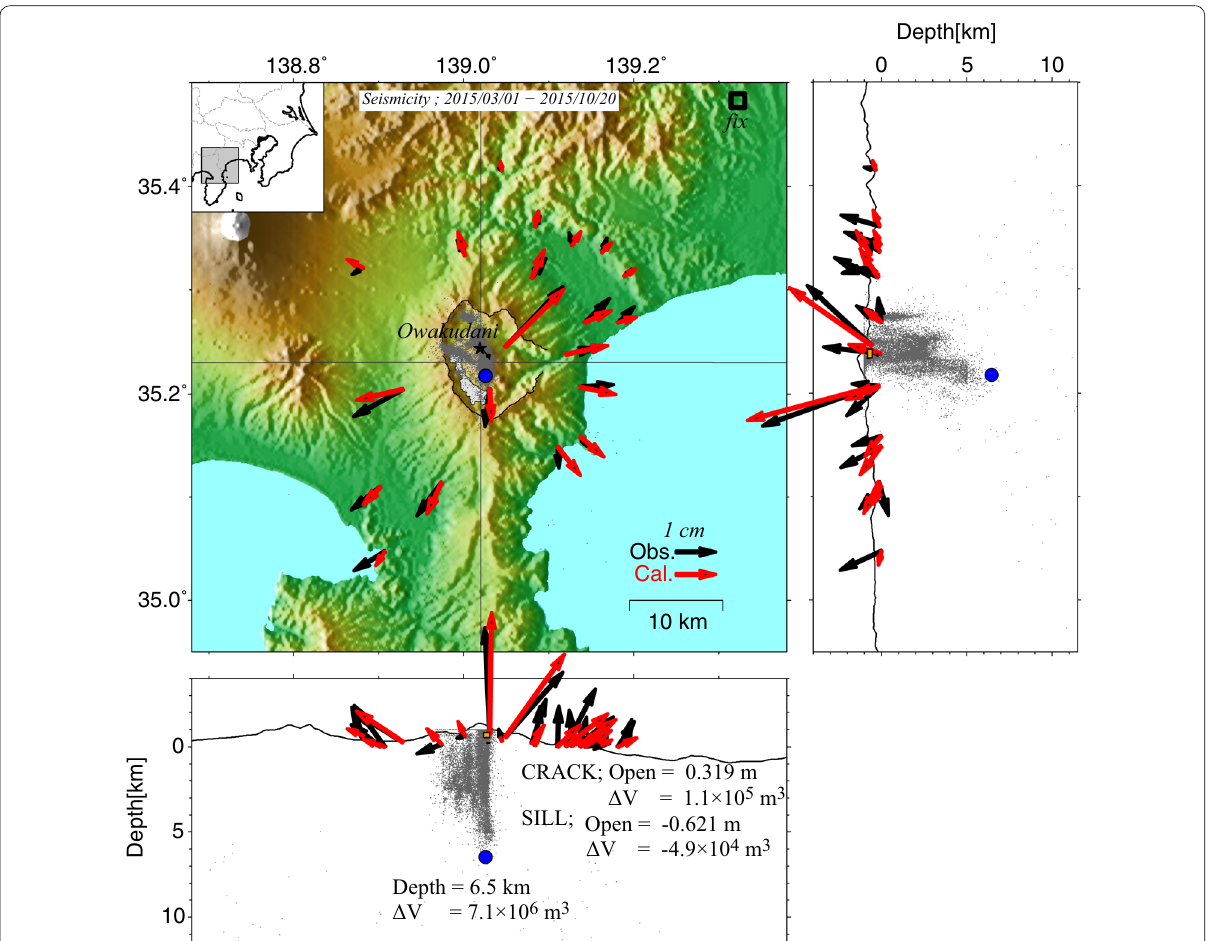
Fig. 1 Vectors indicating the GNSS movements associated with the 2015 unrest of Hakone volcano (black), and those calculated from the deep inflation source (red). Estimated deep inflation source is shown in blue circle. Two other shallow sources are shown in small squares. The gray dots represent seismicity from March 1 to October 20, 2015. The star shows the location of